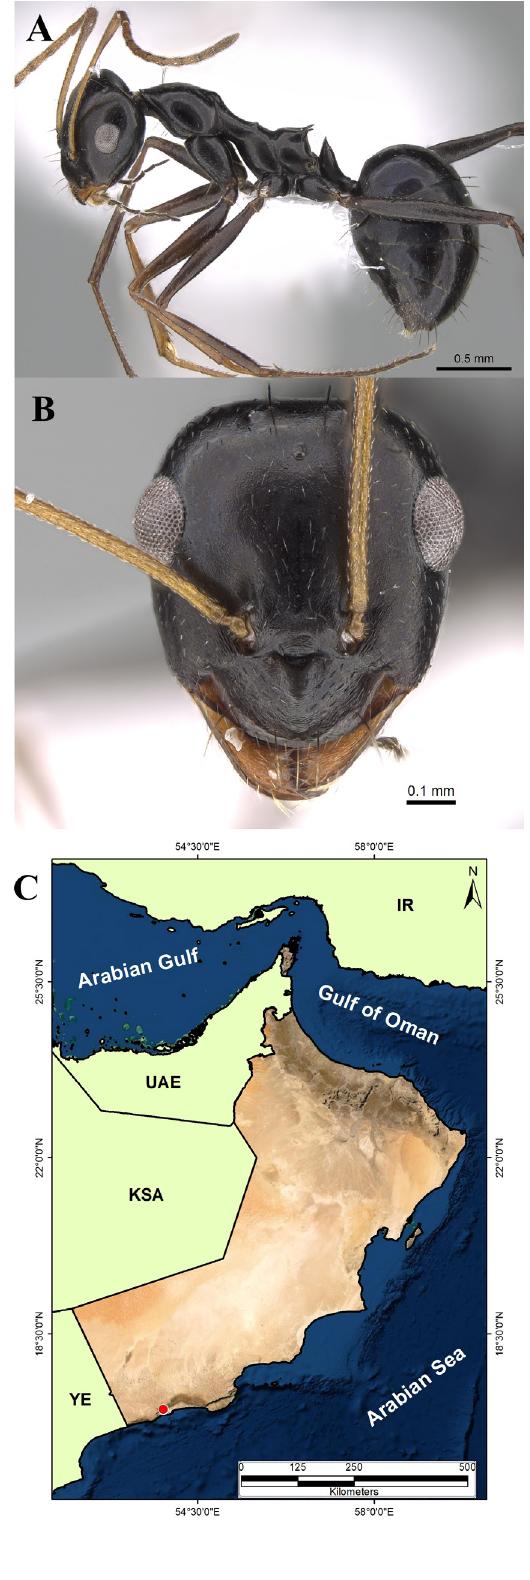
Fig. 20. Lepisiota opaciventris (Finzi, 1936), worker (CASENT0922269, AntWeb.org (Michele Esposito)). A . Body in profile. B . Head in full-face view. C . Distribution